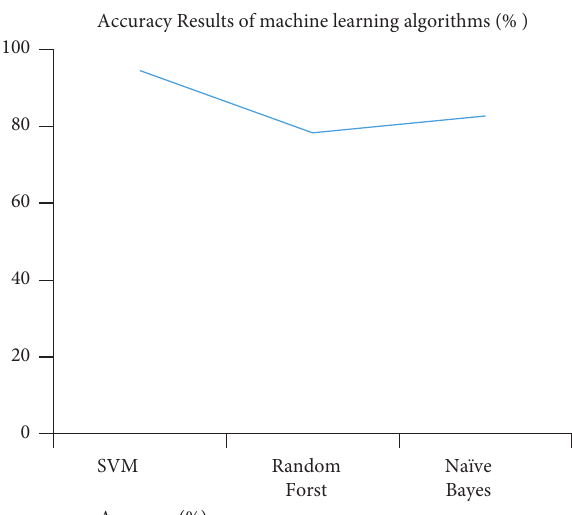
Figure 4: Graphical representation of accuracy results of machine learning algorithms.